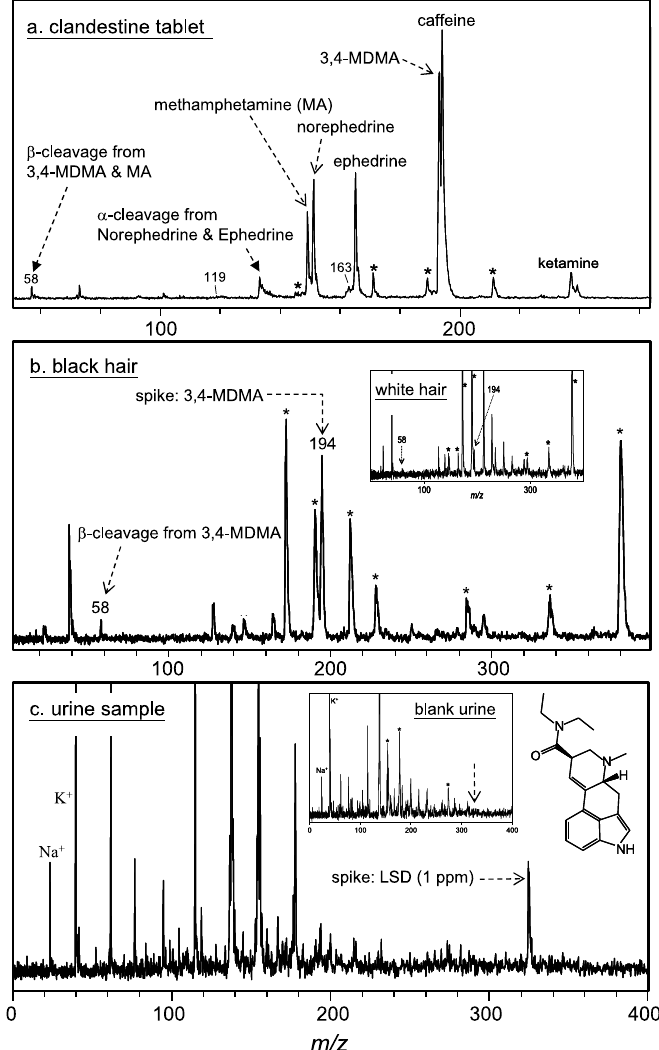
Figure 4. ( a ) MALDI-TOF mass spectrum obtained from an actual clandestine tablet, which was seized from the illicit market in 2001, using CHCA and Nd:YAG laser (355 nm) as the matrix and excitation source, respectively. ( b ) MALDI-TOF mass spectrum for a 3,4-MDMA spiked hair (black color); inset, a 3,4-MDMA spiked white hair. ( c ) MALDI-TOF mass spectrum obtained from of LSD spiked urine sample, using DHB as the matrix. The major fragments of matrix (CHCA) are indicated as “*”.